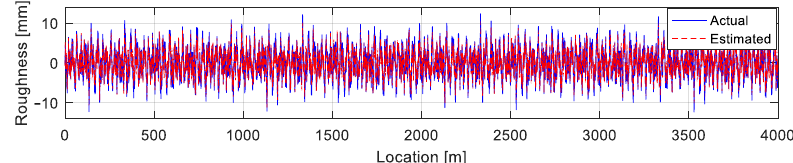
Figure 24. Time histories of the simulated road roughness.